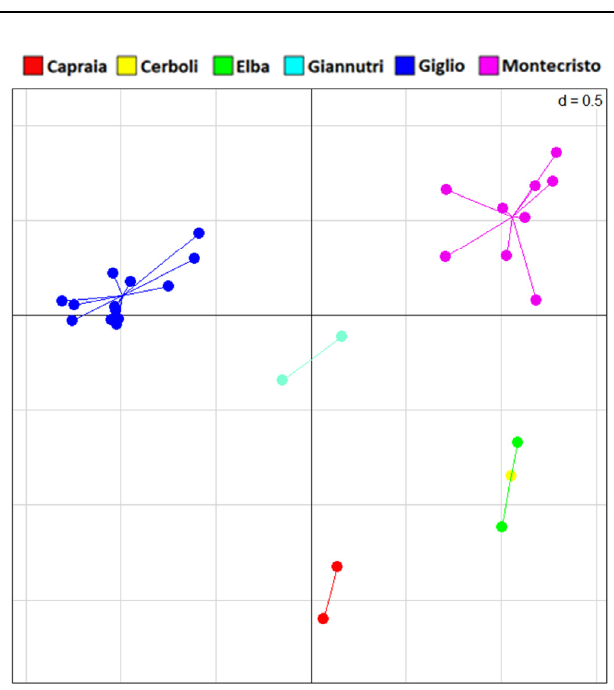
Figure 6. Median joining network built on cytb sequences. Colors represent the three main clades described by Senzcuk et al. [25] and the islands of the Tuscan Archipelago. The Siculo–Calabrian clade includes Sicily, Sardinia, Southern Corsica and the Southern part of Calabria; the Adriatic clade includes Campania, the Adriatic coast, Croatia and the Northern part of Calabria; the Tyrrhe- nian clade includes Giannutri, Montecristo, Cerboli, Northern Corsica and the Tyrrhenian coast. Giglio and Capraia are shown in yellow and green on the right.